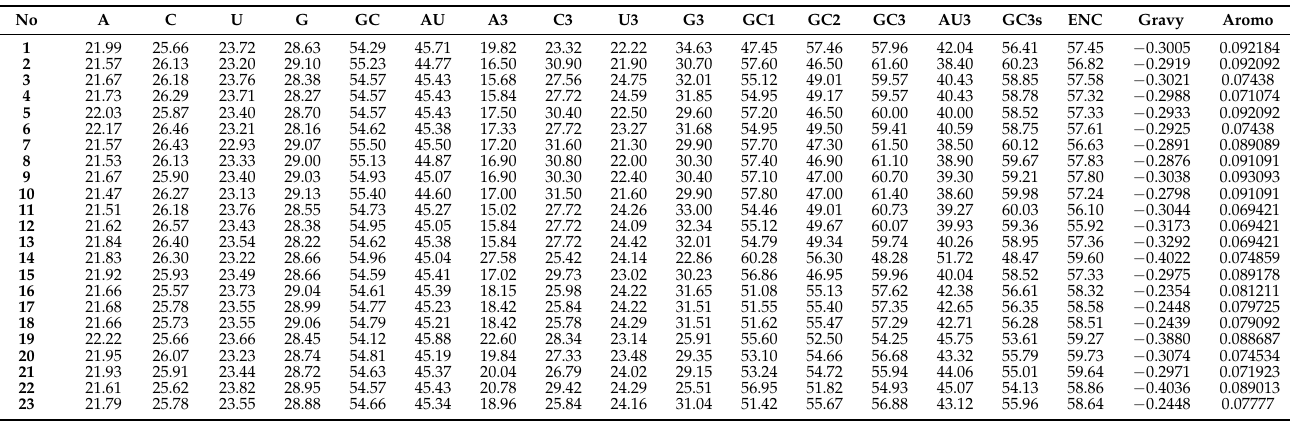
Table 1. A nucleotide compositional analysis of RYMV coding sequences